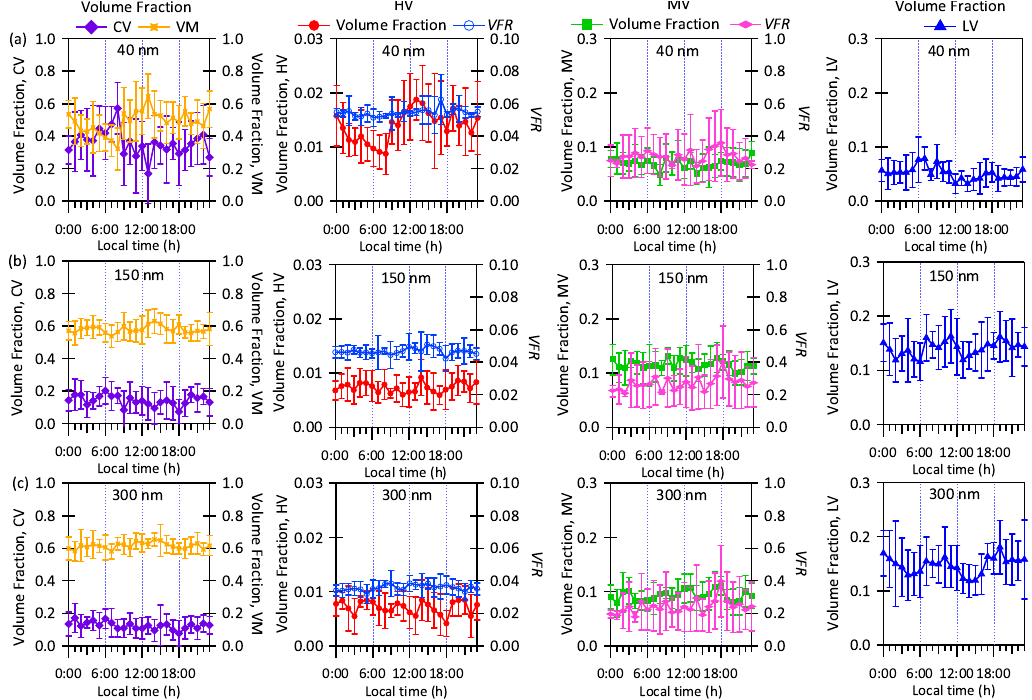
Figure 5. Diurnal variations in the volume fractions of (columns from left to right) CV, VM, HV residuals, MV residuals and LV residuals in (a) 40nm, (b) 150nm and (c) 300nm particles in February and March 2014. Diurnal variations in the volume fraction remaining (VFR) of HV and MV particles are plotted on the right axis. Error bars represent 1 standard